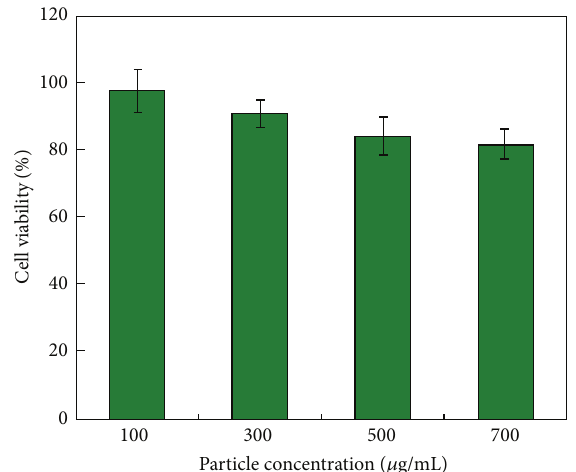
Figure 6: Cytotoxicity profile of ASF microparticles after 24 h incubation with EA926 cells. Percent viability was expressed relative to the control group ( 𝑛 = 3